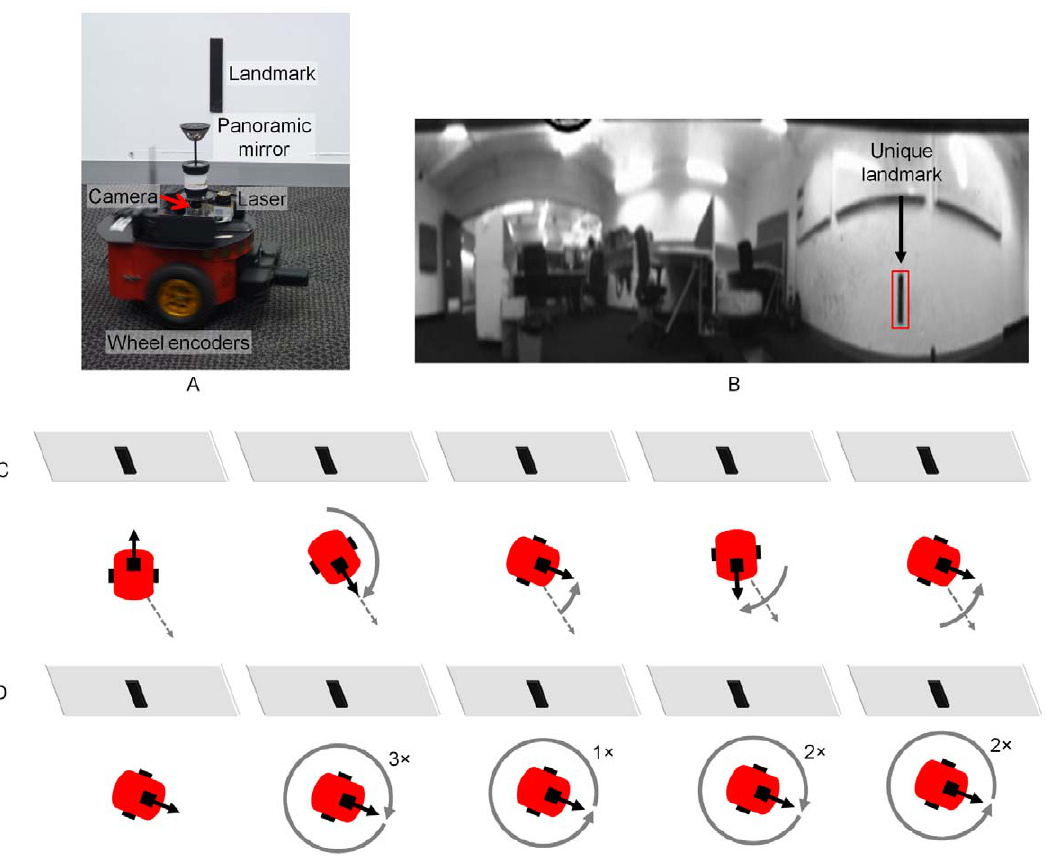
Figure 4. The robot platform, testing environment, and movement schemes. (A) The robot was equipped with a panoramic imaging system, laser and wheel encoders, which provided self-motion data and landmark tracking capabilities. The environment consisted of a typical office room with a distinct and unique black landmark against a white wall background. (B) Panoramic image from the robot’s camera showing the testing environment and the landmark. (C) Movement scheme for the small head turn routine, consisting of small alternating turns, centered around a random initial orientation (shown by the dashed arrow). (D) Movement scheme for 360 u calibration, consisting of alternating turns of 1 to 3 revolutions in either direction.